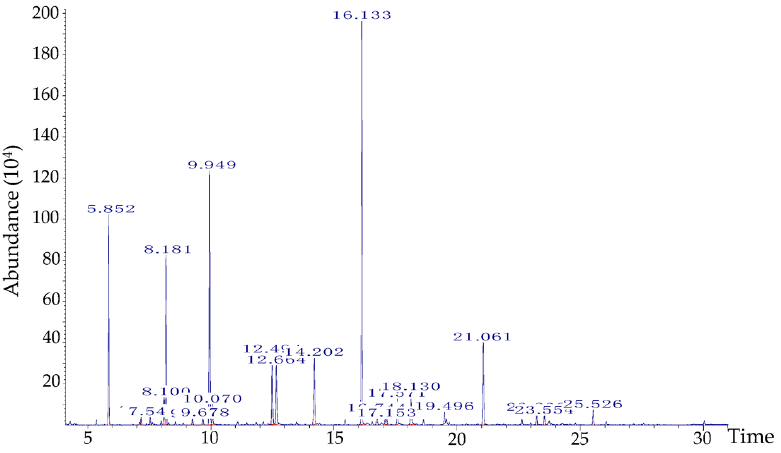
Figure 1. GC-MS chromatogram of Myrtus communis essential